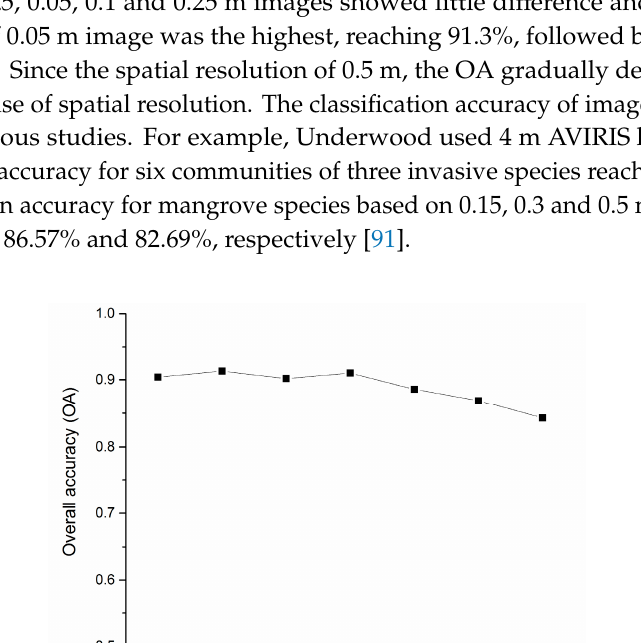
Figure 8. Variation of overall accuracy (OA) with the number of features for multi-scale images.